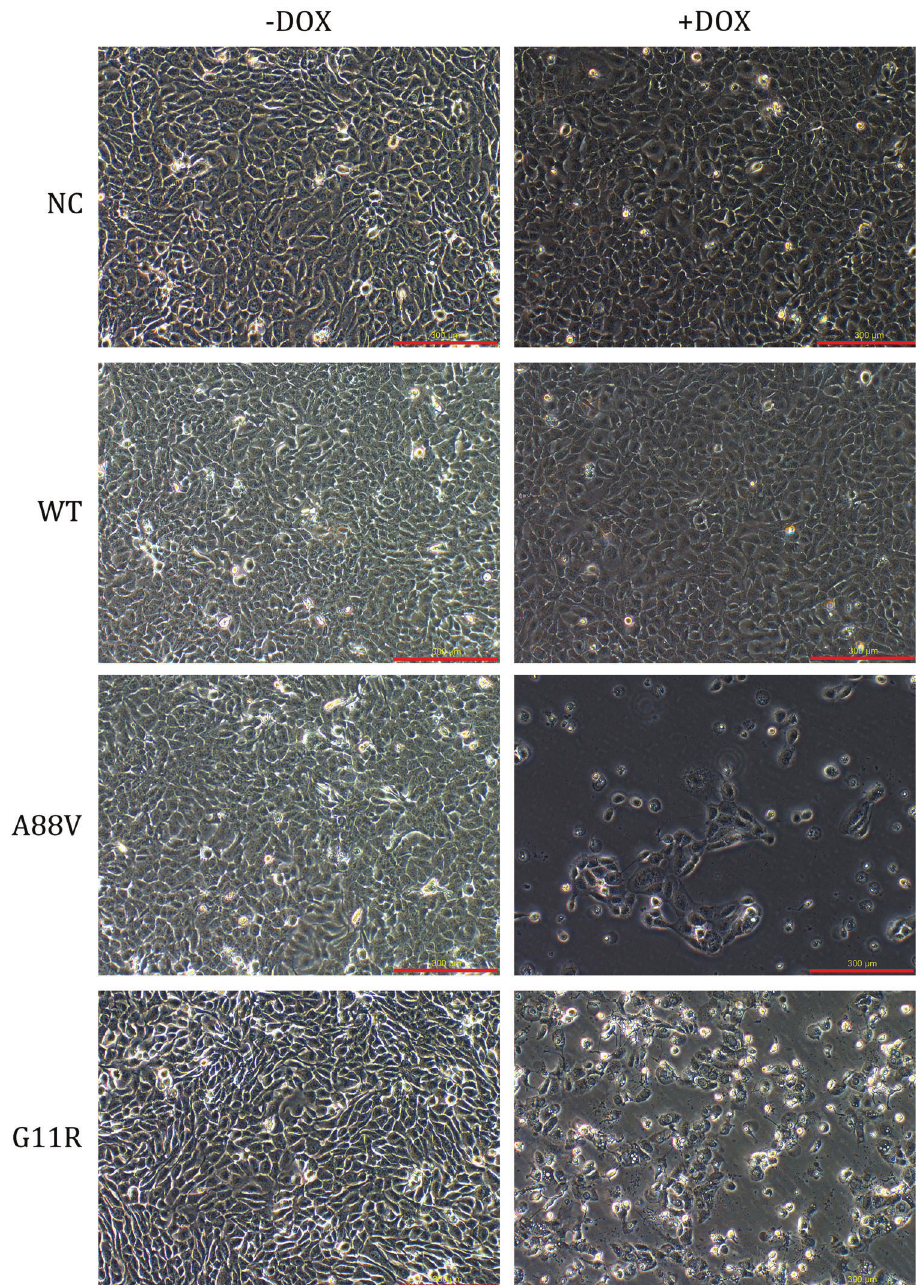
Figure 1. Morphology of cells transfected by negative control virus (NC) and cells expressing wild-type GJB6 gene (WT) were not changed after the cells were induced by doxycycline (DOX). However, the morphology of cells expressing the A88V and G11R